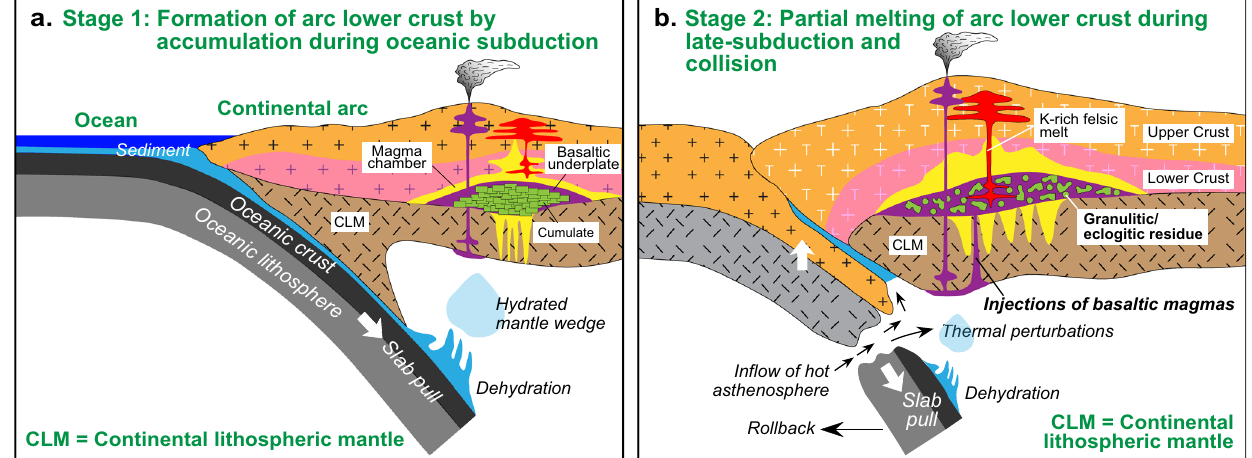
Fig.5|Schematicillustrationofthechemicalmaturationofacontinentalcrust along collision zones starting with a period dominated by fractionation and accumulation followed by a period dominated by remelting of the cumulate pile. a Early formation of (ultra)ma fi c cumulates in the arc lower crust dominated by fractional crystallization during oceanic subduction. b Remelting of the lower